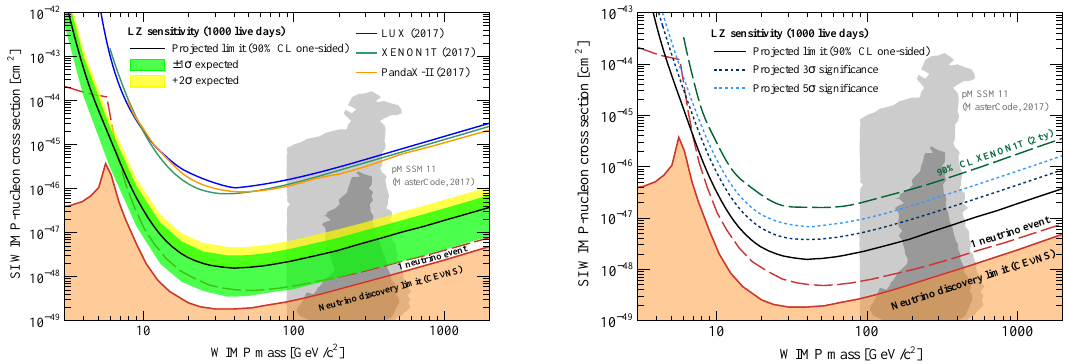
Figure 7. ( Left ) LZ projected sensitivity to spin-independent WIMP-nucleon elastic scattering for 1000 live days and a 5.6 tonne fiducial mass, together with the results from the other LXe experiments. The lower shaded region and dashed line indicate the limitations from the coherent scattering of neutrinos and the grey contoured regions show the favoured regions from recent pMSSM11 model scans (see [4] for a detailed description). ( Right ) LZ discovery potential for spin-independent WIMP-nucleon scattering. The projected sensitivity of a 2 t y exposure of XENON1T [15] is shown for ·